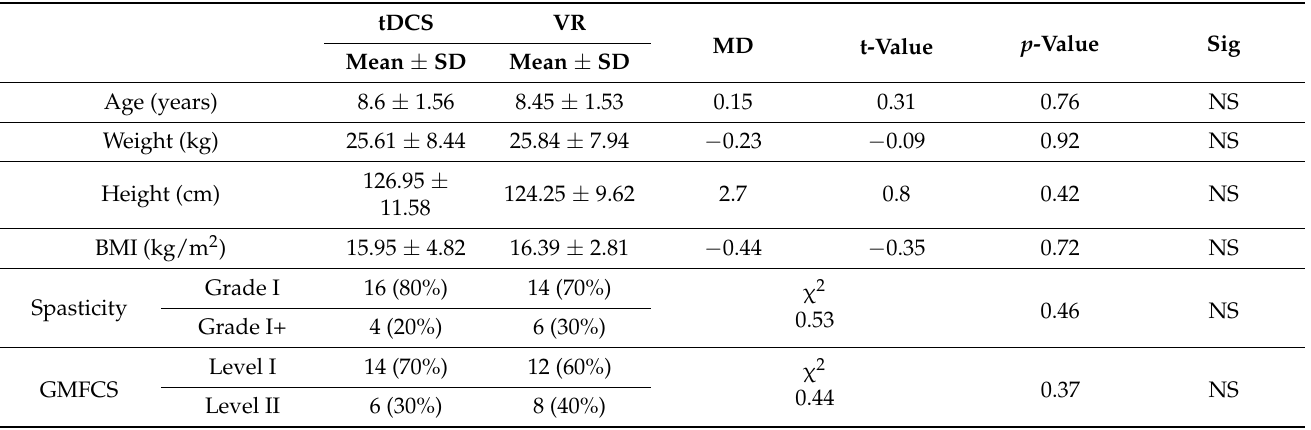
Table 1. Demographics and clinical characteristics of study participants, with between-group com-